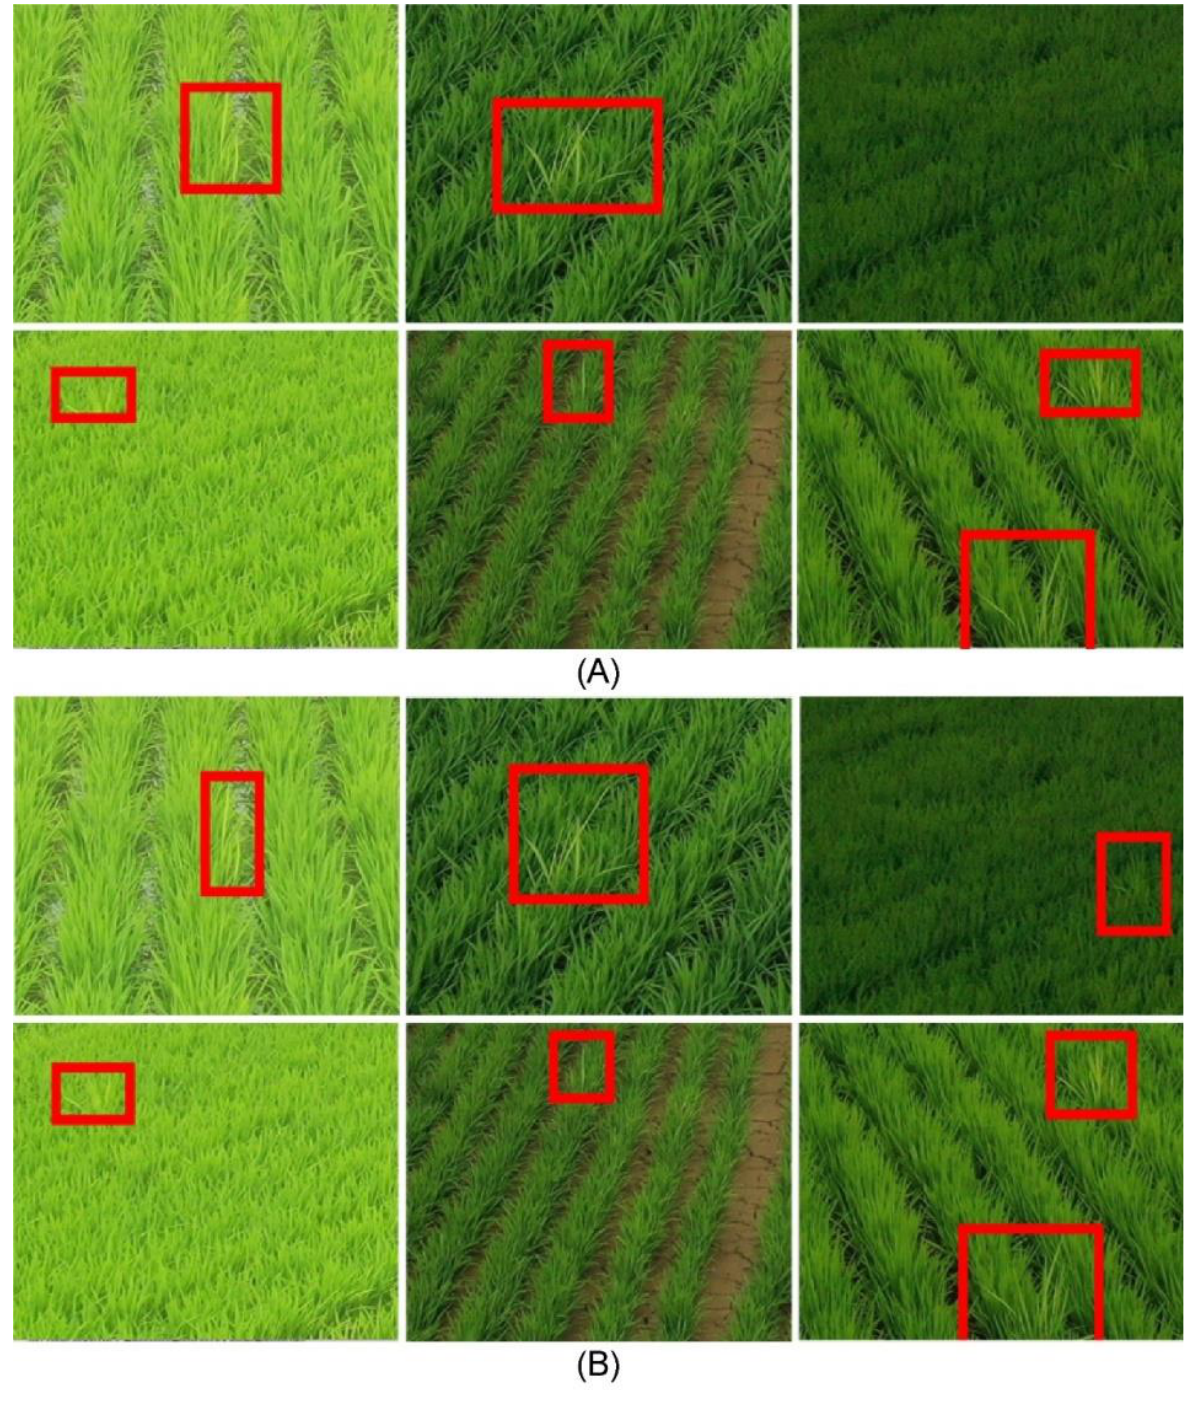
Figure 19. The detection results of RBD bunch area for patch segmentation data (Red boxes represent detected RBD-infected bunches): ( A ) warm up and label smoothing technique not applied, and ( B ) warmup and label smoothing techniques applied.